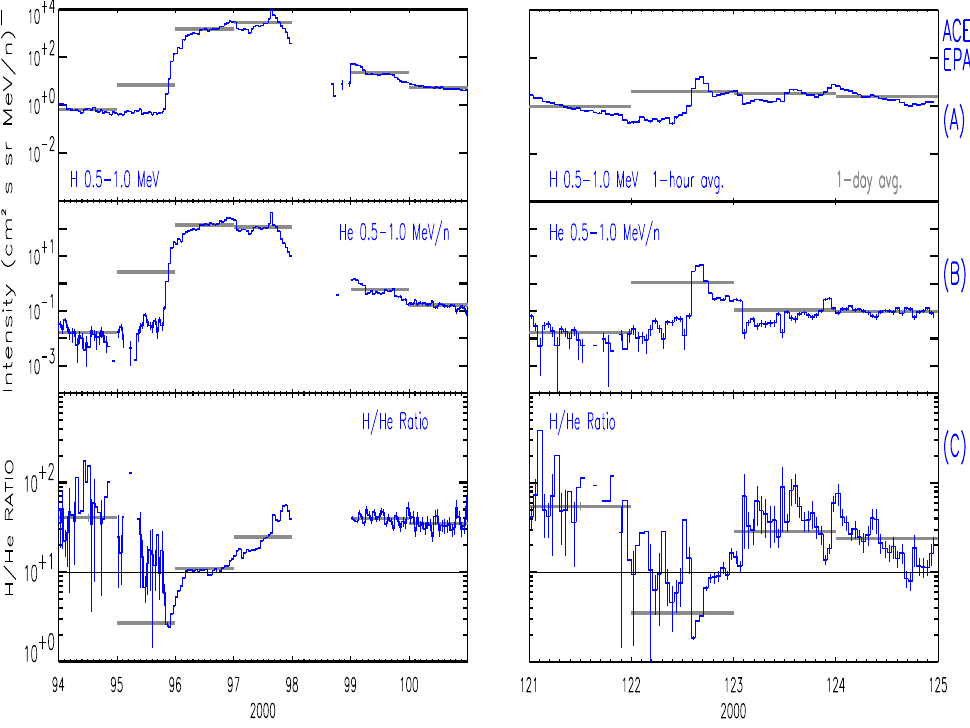
Fig. 5. One-hour (black traces) and 1-day (gray horizontal lines) averages of the (A) 0.5–1.0 MeV proton intensity and (B) 0.5–1.0 MeV/nucleon helium intensity as measured by the EPAM instrument on ACE (Gold et al., 1998) for two different SEP events observed in 2000. (C) H/He ratio calculated from the H and He traces shown in panels (A) and